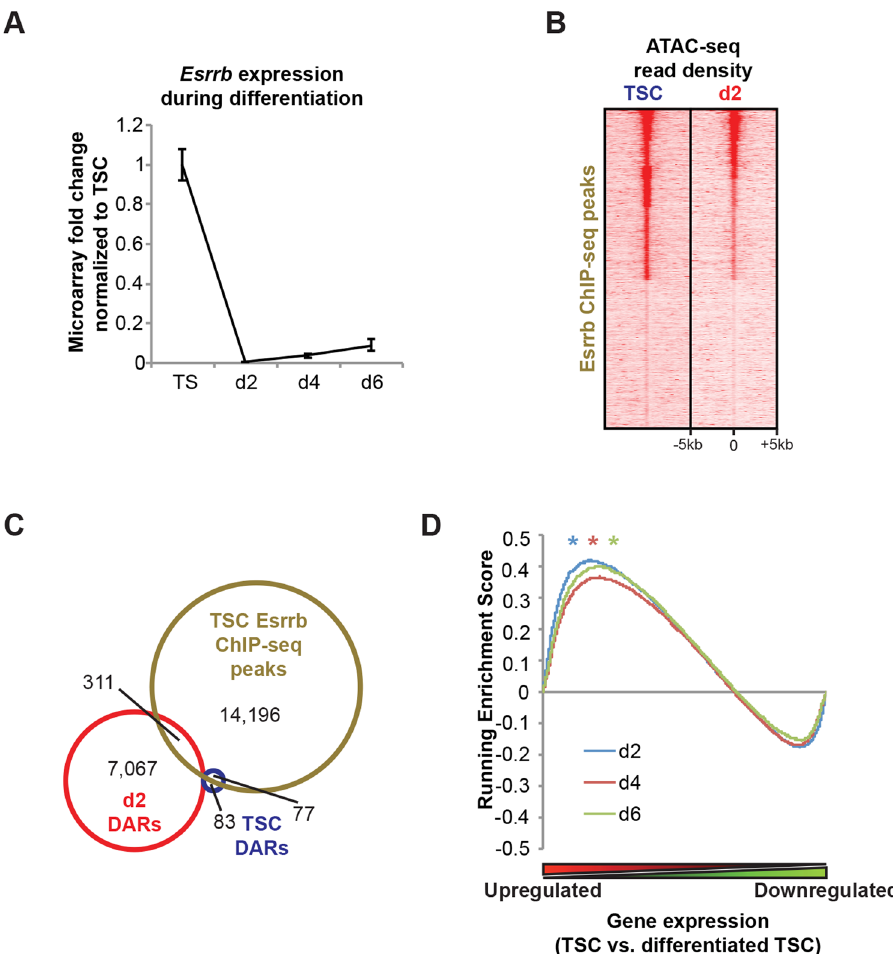
Figure 4. TSC gene expression controlled by the Fgf-dependent transcription factor Esrrb. ( A ) Microarray analysis of Esrrb expression during TSC differentiation. Fold change relative to TSC is shown. Data represents means ± S.E.M., n ≥ 8 per stage. ( B ) Heatmap of TSC and d2 ATAC-seq data at Esrrb TSC ChIP-seq coordinates. ( C ) Overlap of Esrrb ChIP-seq peaks with TSC and d2 DARs. See also Supplementary Figure S2. ( D ) Gene Set Enrichment Analysis comparing Esrrb ChIP-seq peaks and microarray changes in gene expression at three stages of in vitro differentiation compared with TSCs. * P < 1 × 10 − 3